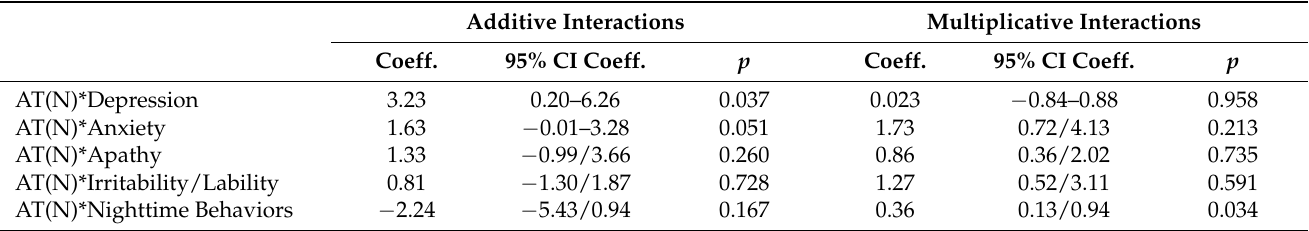
Table 6. Additive and multiplicative interactions in Cox regression analysis for ATN and